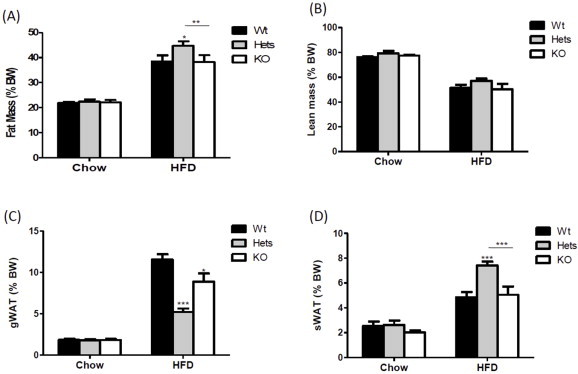
Effect of Fto-deficiency on anthropometric measurements of 13 weeks old male mice either on standard chow or 5 weeks of 60% HFD expressed as percentage of body weight. (A) Total fat mass; (B) total lean mass measured by dual-energy X-ray absorptiometry (DEXA). (C) Weights of dissected epididymal white adipose tissue and (D) subcutaneous weight adipose tissue. Black bars denote Fto+/+ (n = 17 chow, n = 13 HFD); grey bars denote Fto+/− (n = 20 chow, n = 13 HFD); white bars denote Fto−/− (n = 13 chow, n = 10 HFD). *p < 0.05; **p < 0.01; ***p < 0.001 following two-tailed t-test.